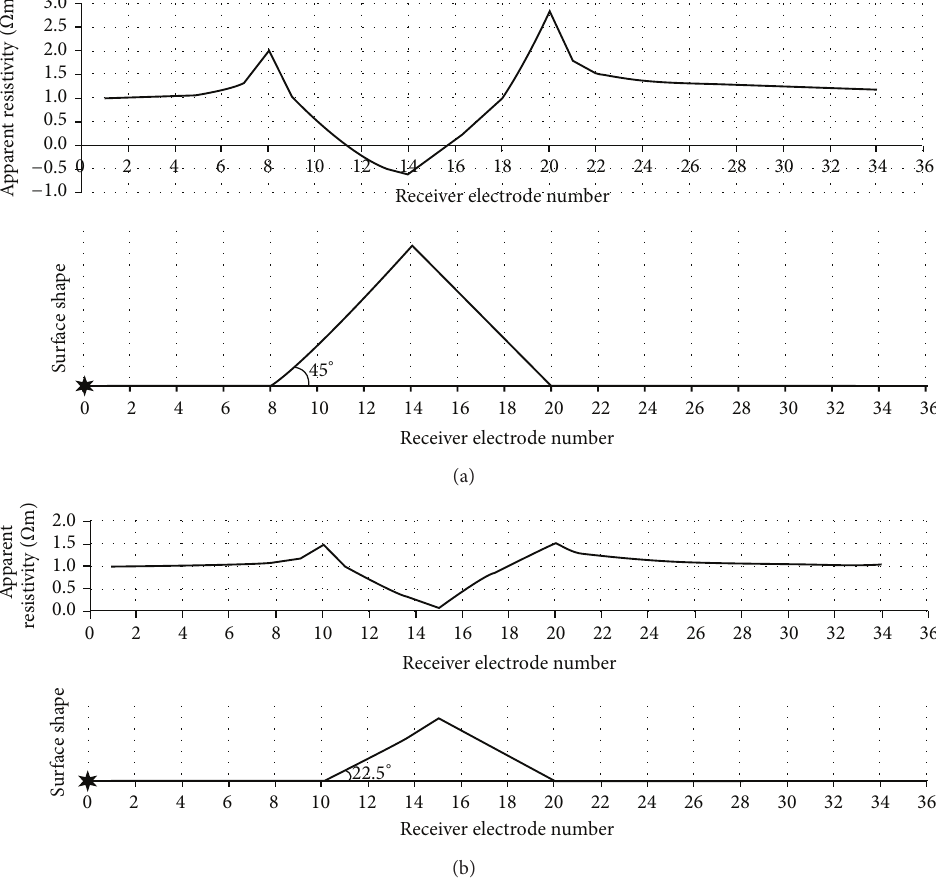
Figure 6: The form of the ground surface and 𝜌 𝑎 curves for a three-electrode array where the model surface has positive shape of symmetrical triangle. A star indicates the position of the current source electrode. (a) The angle of 𝛼 = 45 ∘ ; (b) the angle of 𝛼 = 22.5 ∘